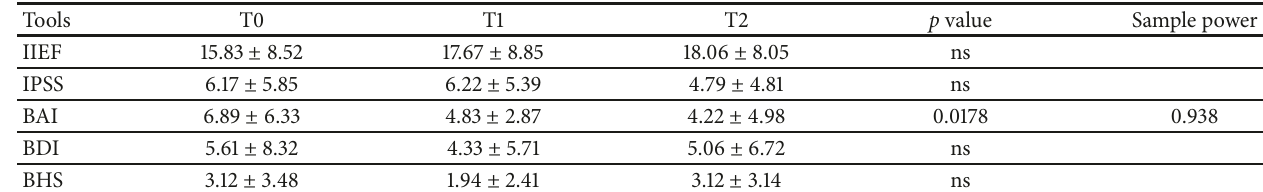
Table 1: Scores at Times 0, 1, and 2.